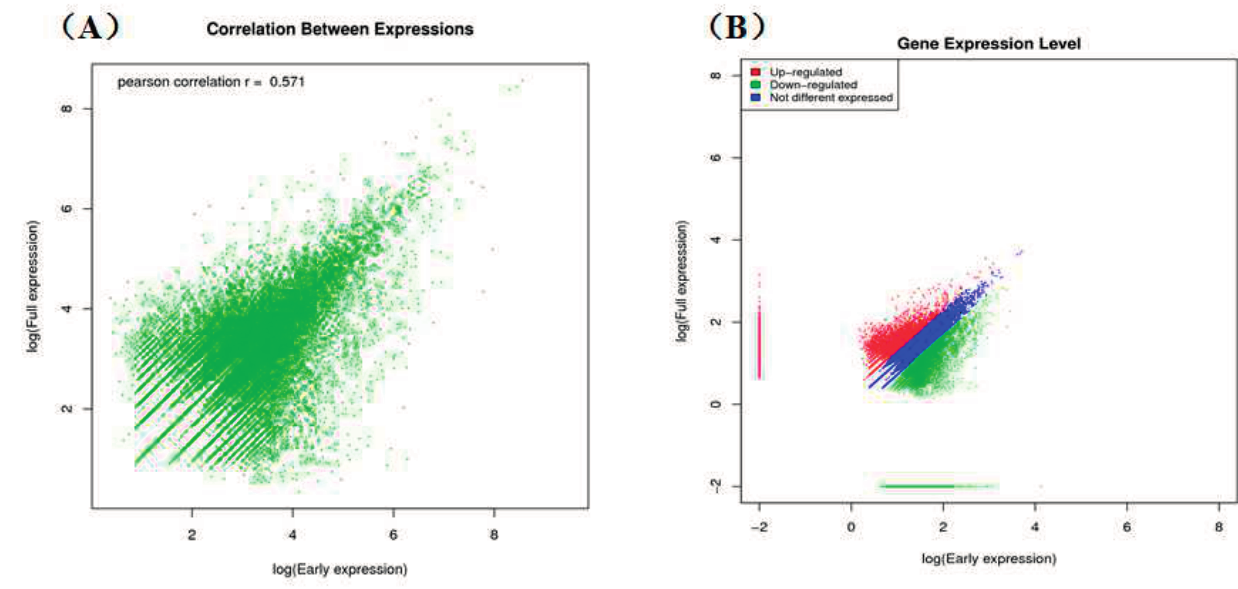
Figure 4. The scatter of expressed genes in the early and full flowering stages of safflower. The blue dots represent genes that are not differentially expressed, and the red and green dots represent up-regulated and down-regulated genes, respectively. ( A ) Correlation between expression in the early and full flowering stages of safflower; ( B ) Gene expression level in the early and full flowering stages of